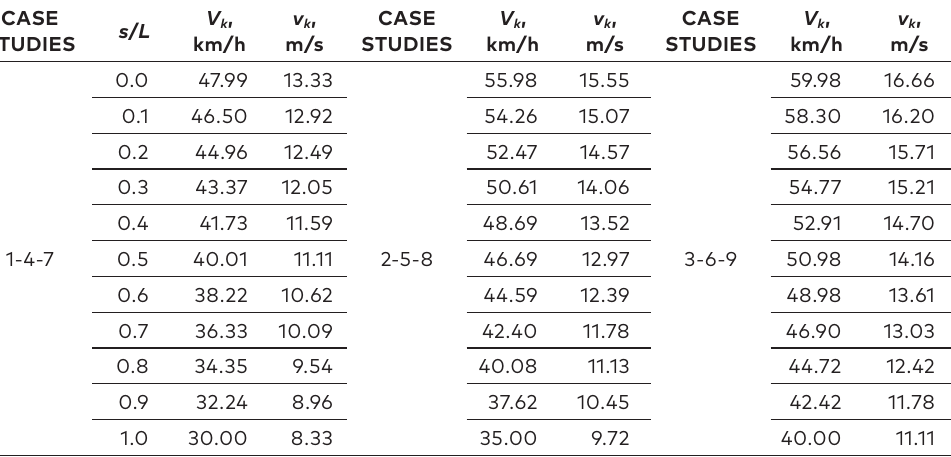
Table 9. Speed along transition curves (case studies